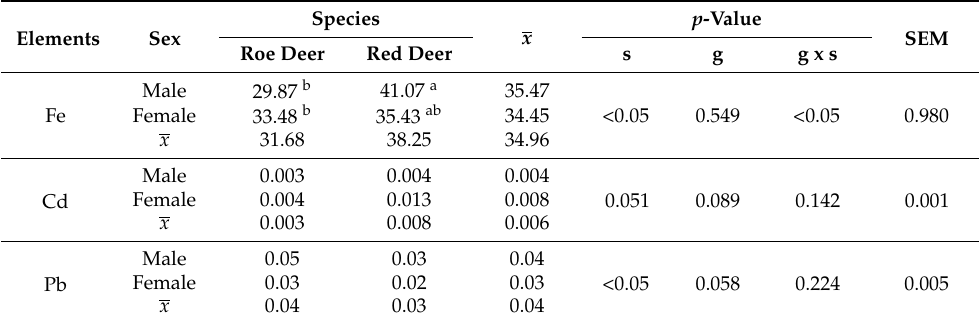
Table 2. Contents (mg/kg) iron, lead and cadmium of haunch.